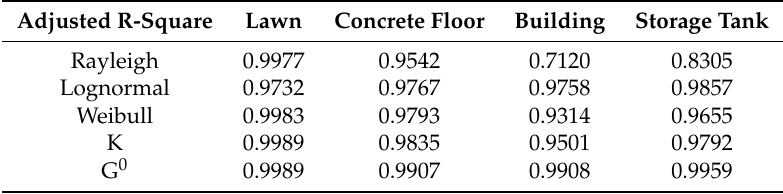
Table 3. The adjusted R-square values of the fitting